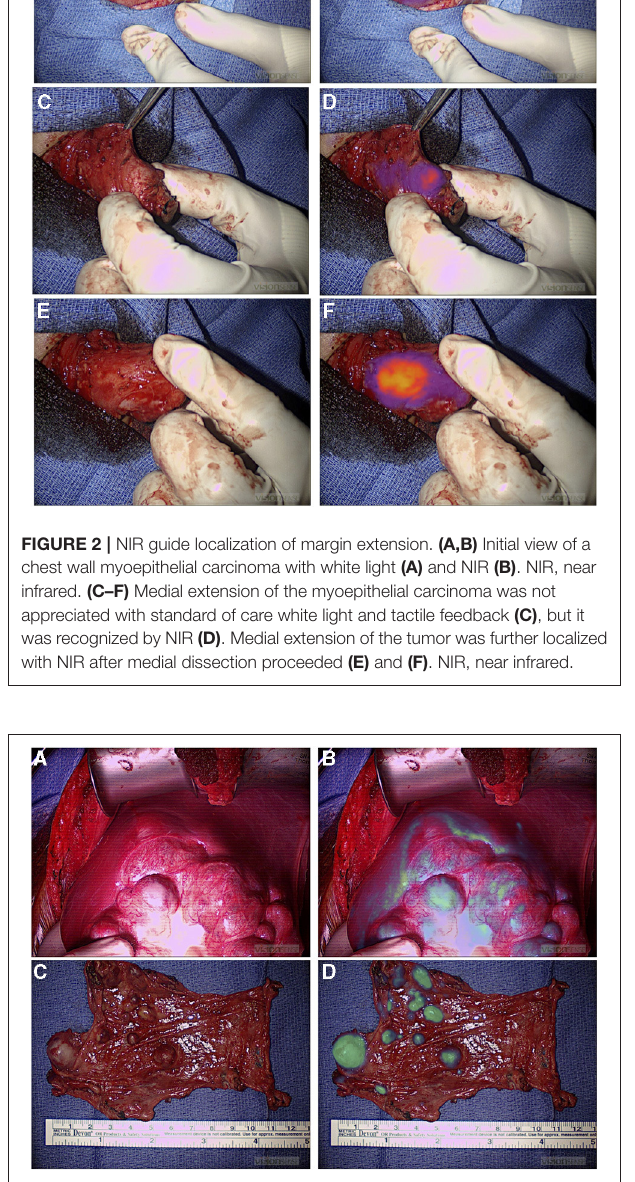
FIGURE 3 | NIR localization of primary and metastatic liver tumors. (A,B) White light (A) and NIR (B) view of a primary liver hepatoblastoma. (C,D) White light (C) and NIR (D) view of hepatocellular carcinoma peritoneal metastases. NIR, near